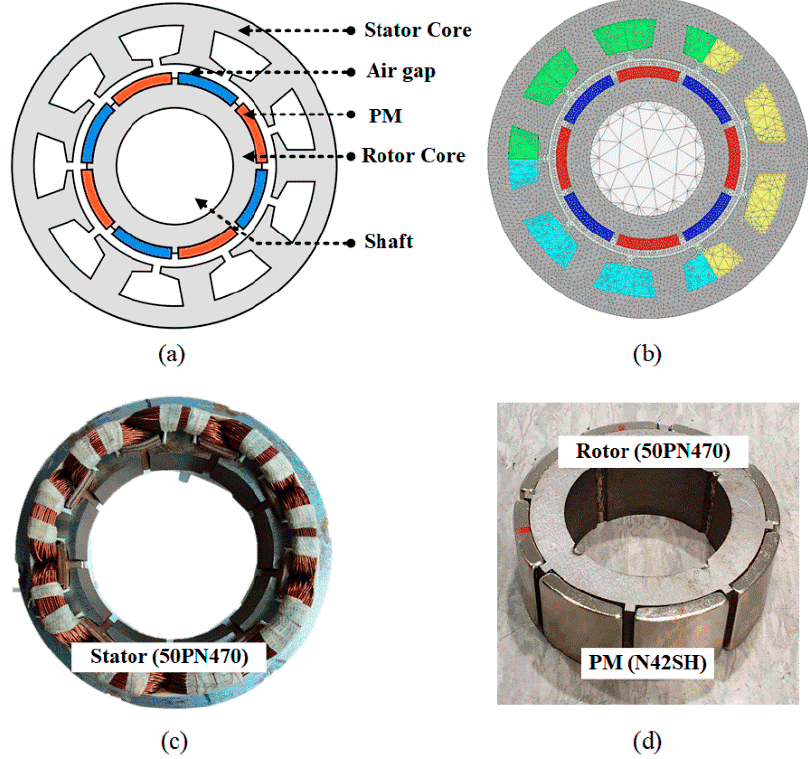
Figure 1. Analysis model: ( a ) eight-pole nine-slot permanent magnet synchronous machine (PMSM); ( b ) the mesh plot of analysis model; ( c ) manufactured stator; and ( d ) manufactured rotor.